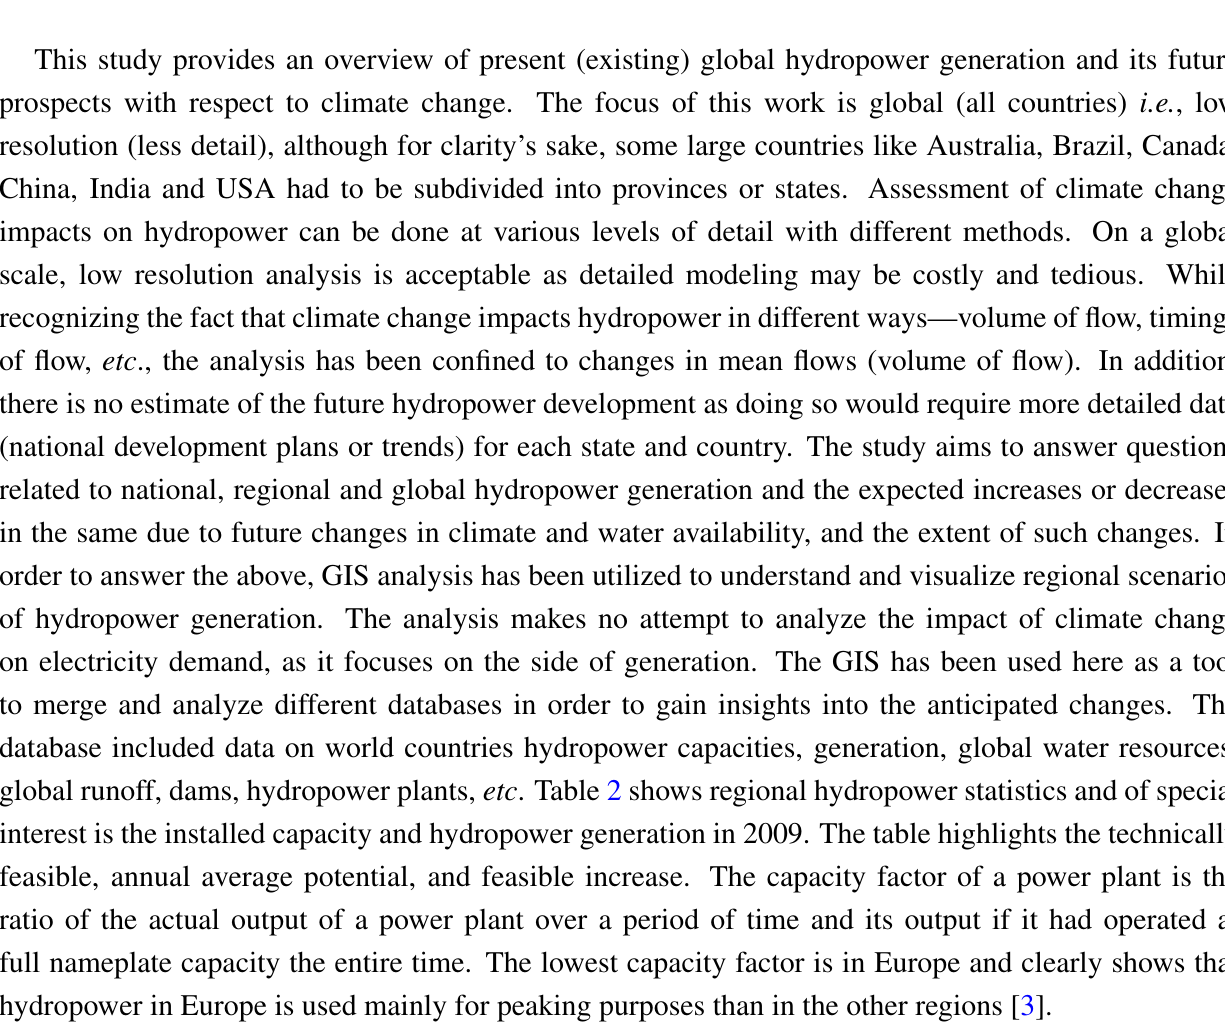
Regional Hydropower Potential (2009). feasible, annual average potential, annual generation capacity, and feasible increase [3].